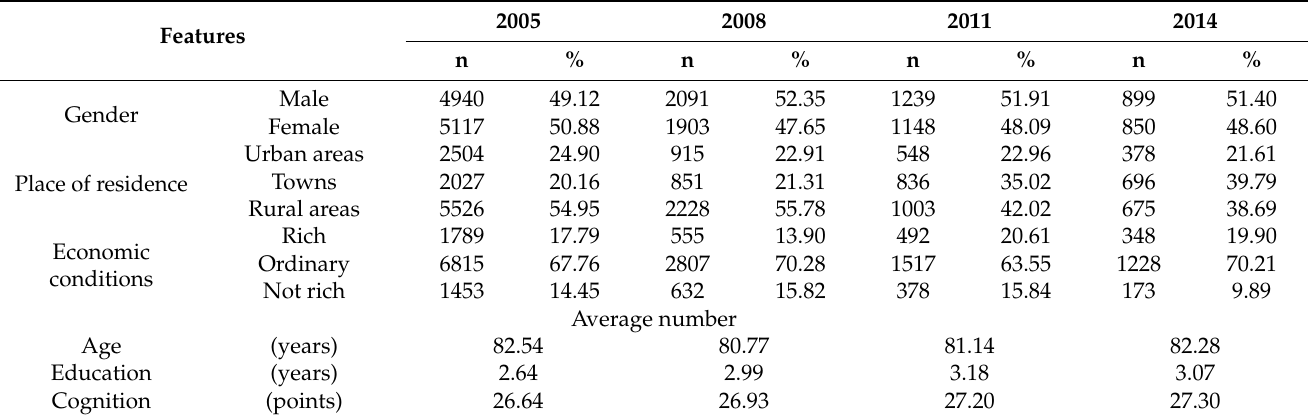
Table 1. Basic conditions of elderly people